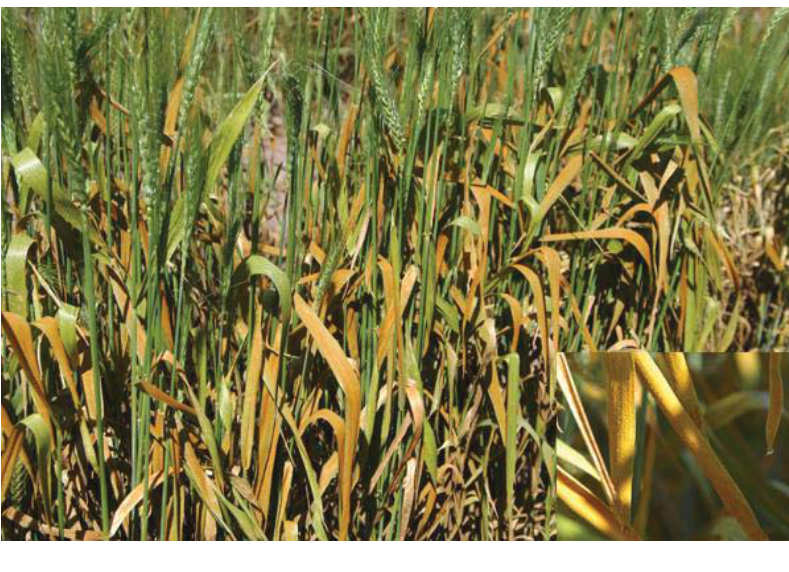
Figure 7. Plots of wheat germplasm lines inoculated with Puccinia triticina . Photo courtesy of Xiuling Zhang, University of